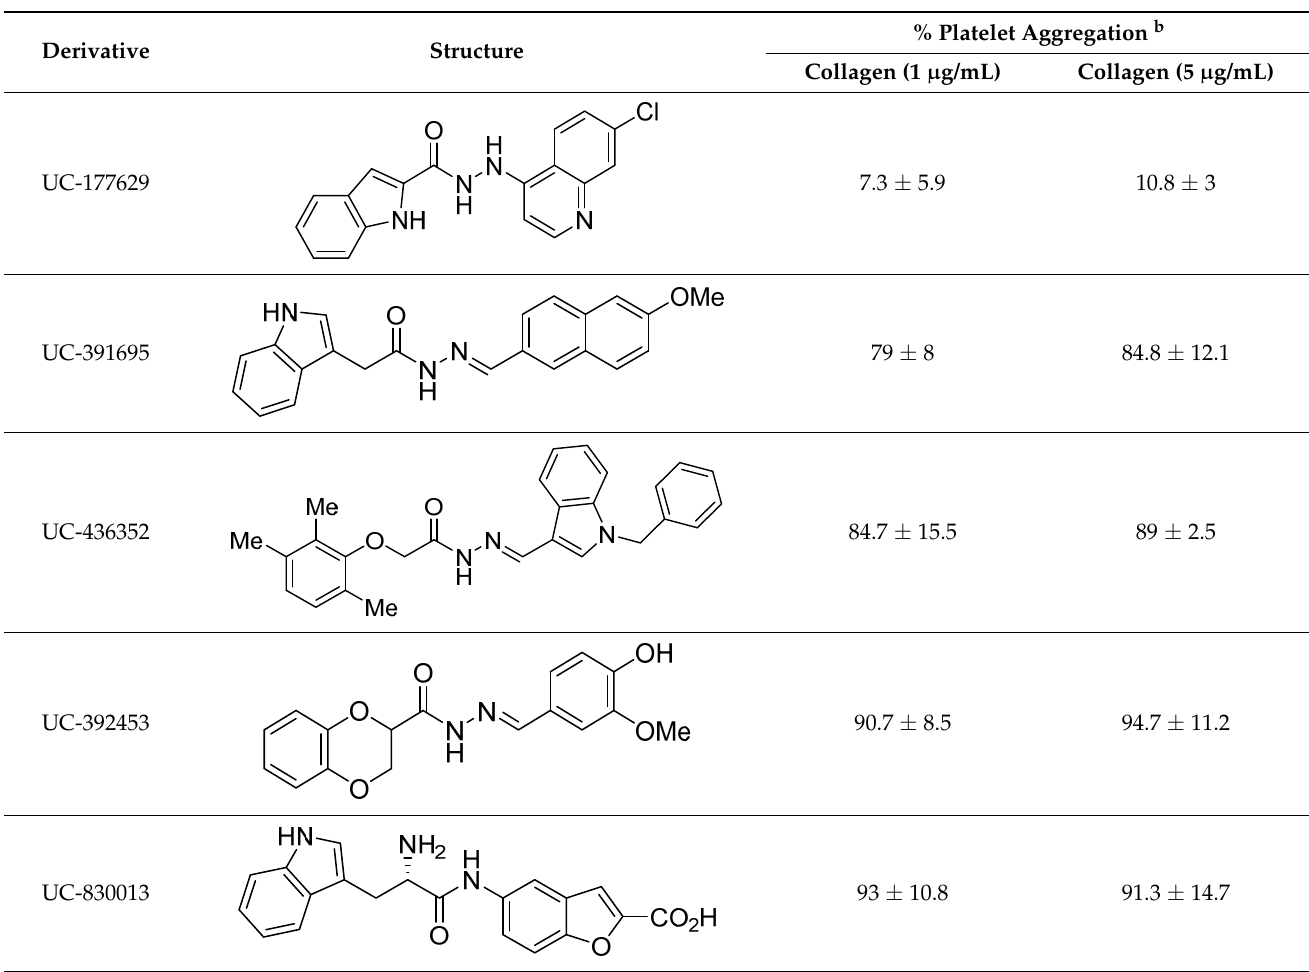
Table 1. Structures of Rhosin-related compounds and their effects at 20 µ M concentration on in vitro collagen-induced platelet aggregation.